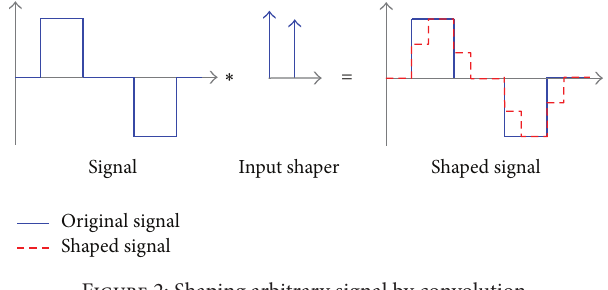
Figure 2: Shaping arbitrary signal by convolution. Table 1: Limit values of joint velocities and angles.